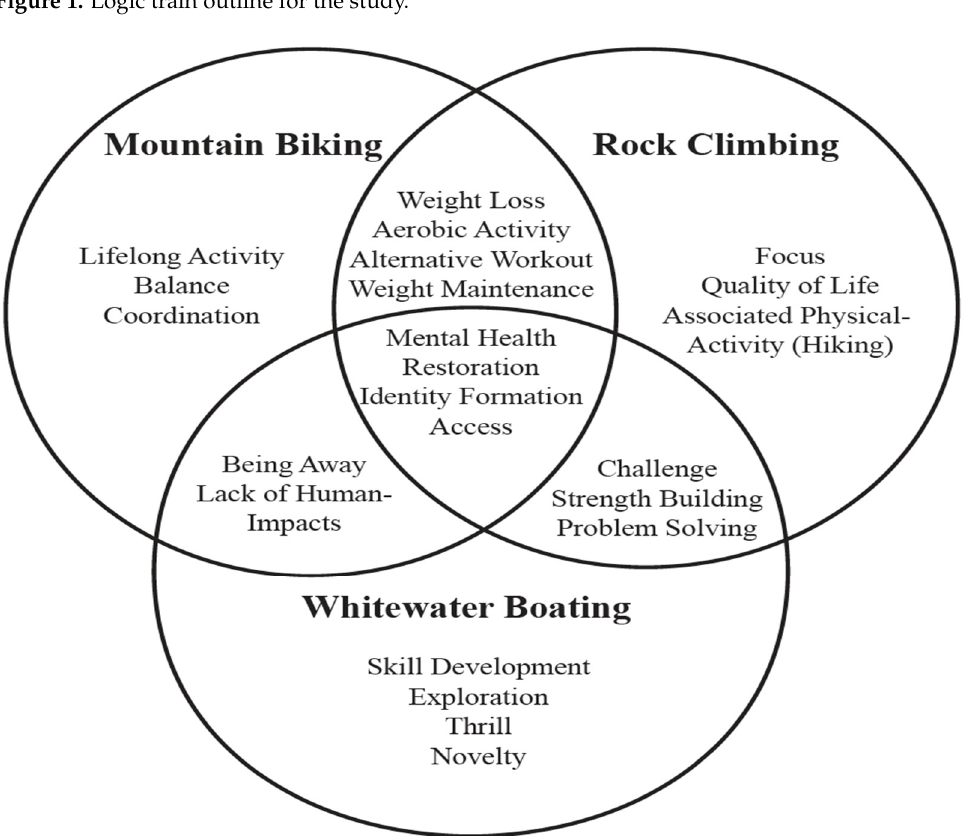
Figure 2. Comparison of common themes by OAR activity.